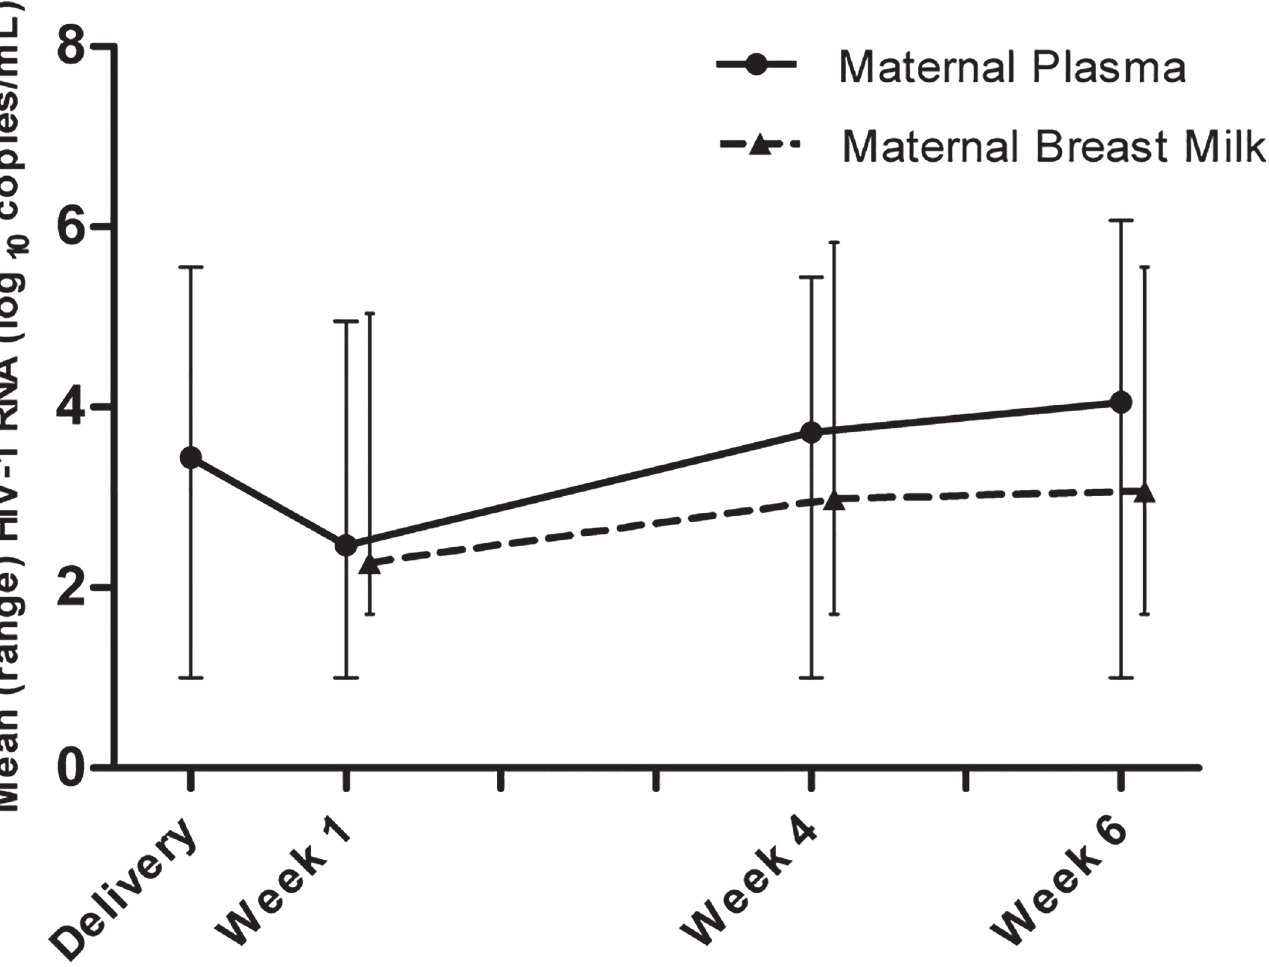
Fig 3. Mean log 10 HIV-1 RNA in Maternal Plasma and Breast Milk from 273 HIV-Infected Women. Ranges are represented with error bars. The mean at delivery is based on 223 plasma samples. The means at 1 week postpartum are based on 227 plasma samples and 207 breast milk samples. The means at 4 weeks postpartum are based on 228 plasma samples and 198 breast milk samples. The means at 6 weeks postpartum are based on 252 plasma samples and 208 breast milk samples. doi:10.1371/journal.pone.0121111.g003 HIV-1 RNA mean level at 1 week postpartum was 2.28 log copies/mL (range, 1.70 to 5.04 10